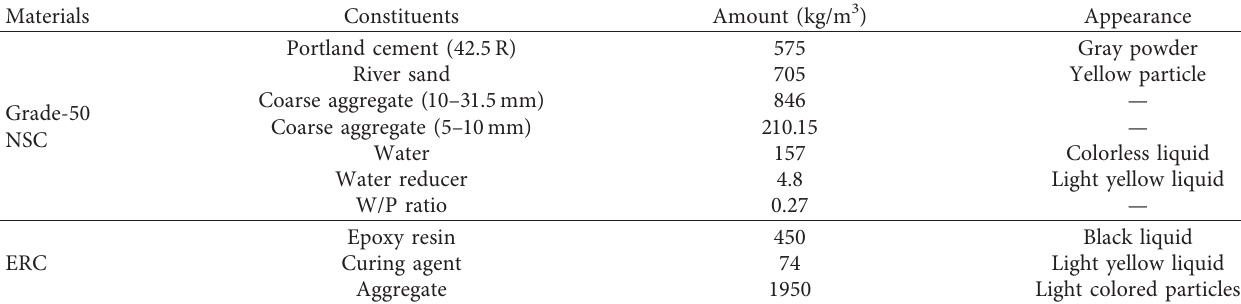
Table 2: Mix proportions of NSC and ERC.